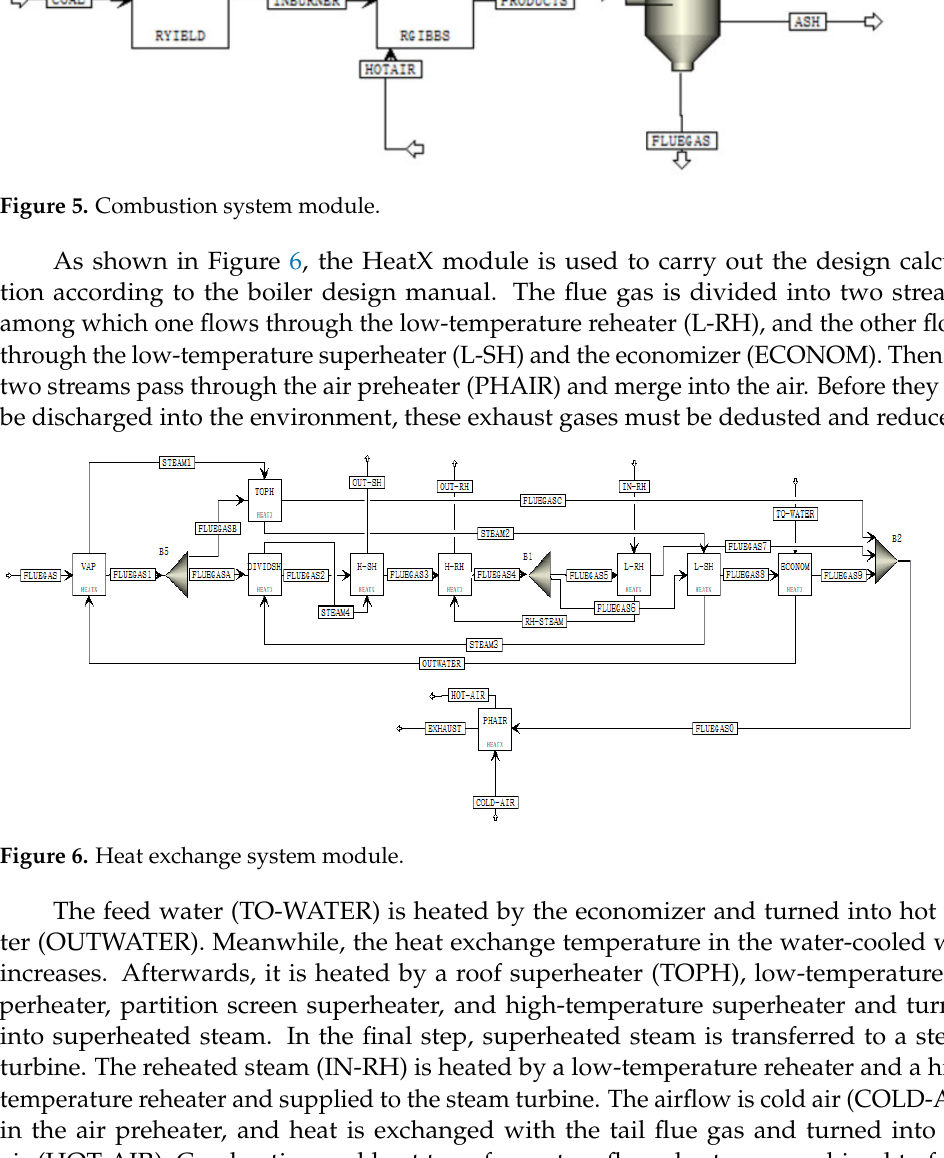
Figure 6. Heat exchange system module.